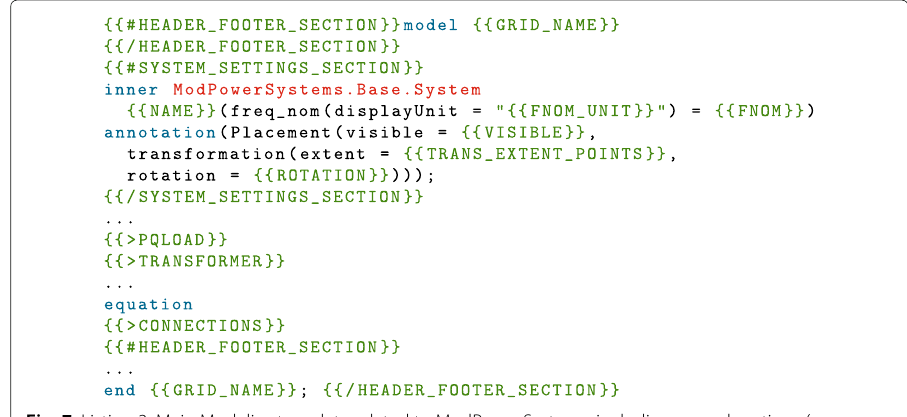
Fig. 7 Listing 3: Main Modelica template related to ModPowerSystems, including several sections (e.g. SYSTEM_SETTINGS ) and subtemplates (e.g. PQLOAD